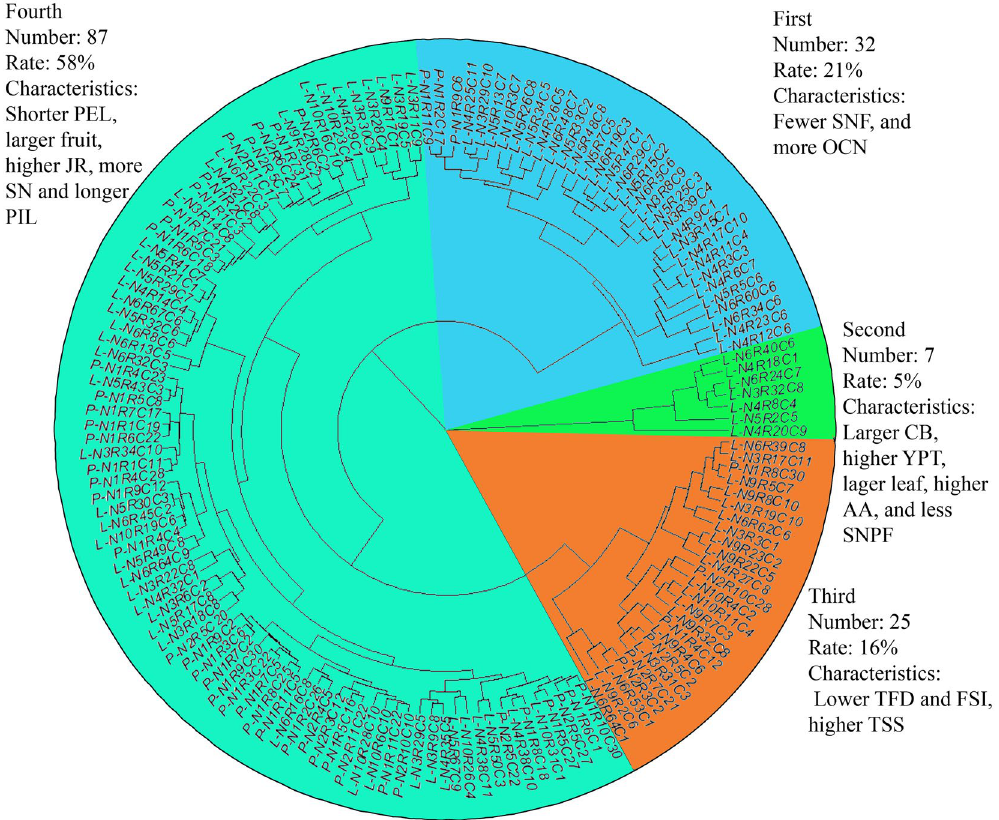
Figure 3. Sample cluster map. The figure shows the cluster analysis results of 151 individuals based on phenotypic traits. The results show that the populations were divided into 4 categories, which was indicated by blue, green, orange and dark green colors The number, proportion and characteristics of each category were showed in the figure (figure is generated by R software, Version R 4.1.1, https:// www.r- proje ct. org/).